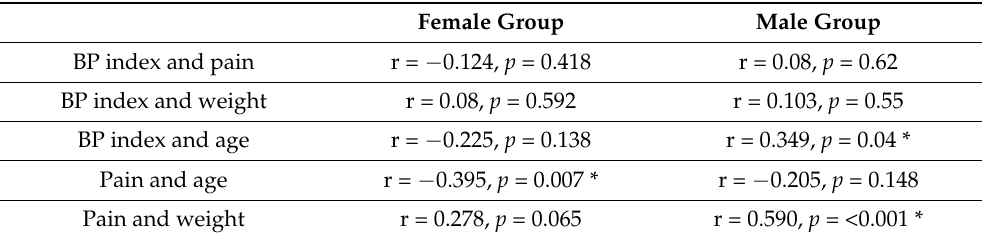
Table 2. Correlations between variables in female and male